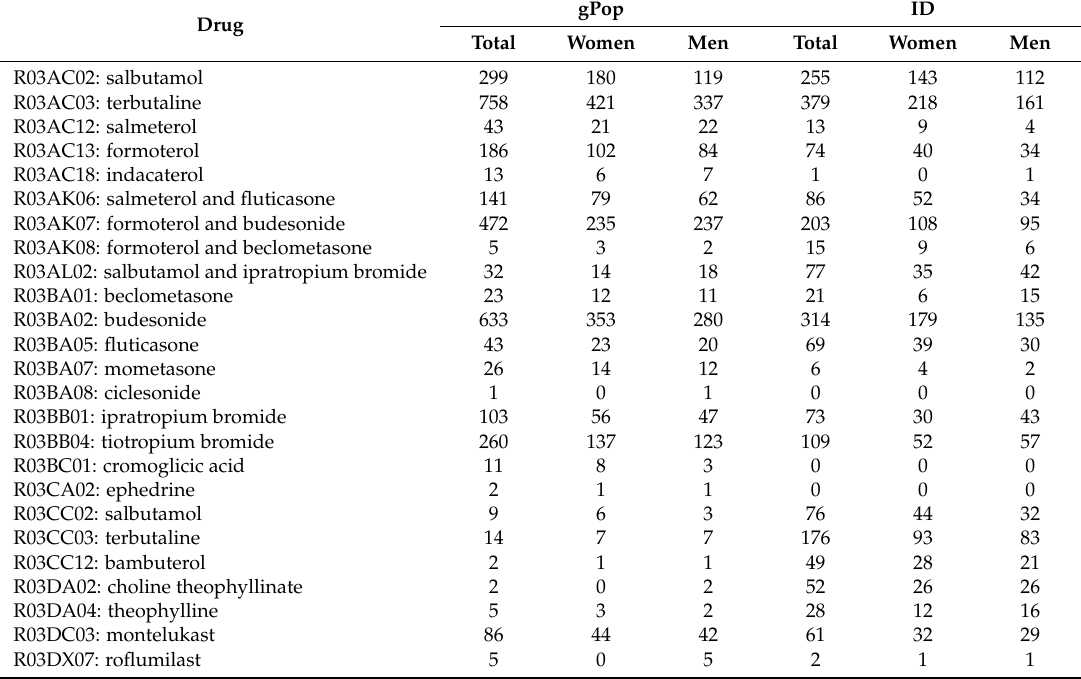
Table 2. The number of people with at least one prescription of drugs for obstructive airway diseases (ATC-code R03) in a cohort of people with intellectual disabilities (ID) and a referent sample from the general population